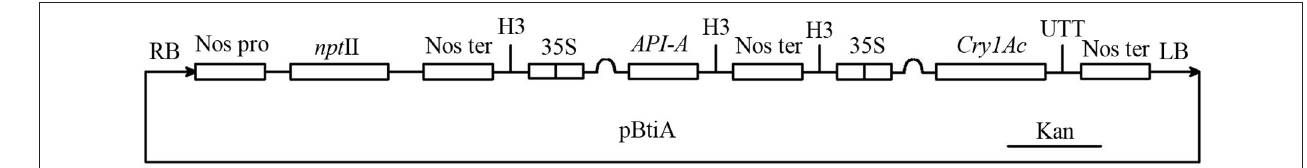
FIGURE 1 | Construction of the pBtiA plant expression vector containing API-A and Cry1Ac genes. Nos pro, promoter of neomycin phosphotransferase gene; npt II, neomycin phosphotransferase gene; Nos ter, terminator of neomycin phosphotransferase gene; 35S, cauliflower mosaic virus 35S promoter; API-A , arrowhead proteinase inhibitor gene; Cry1Ac , Bacillus thuringiensis insecticidal crystal protein gene (Tian et al., 2000).